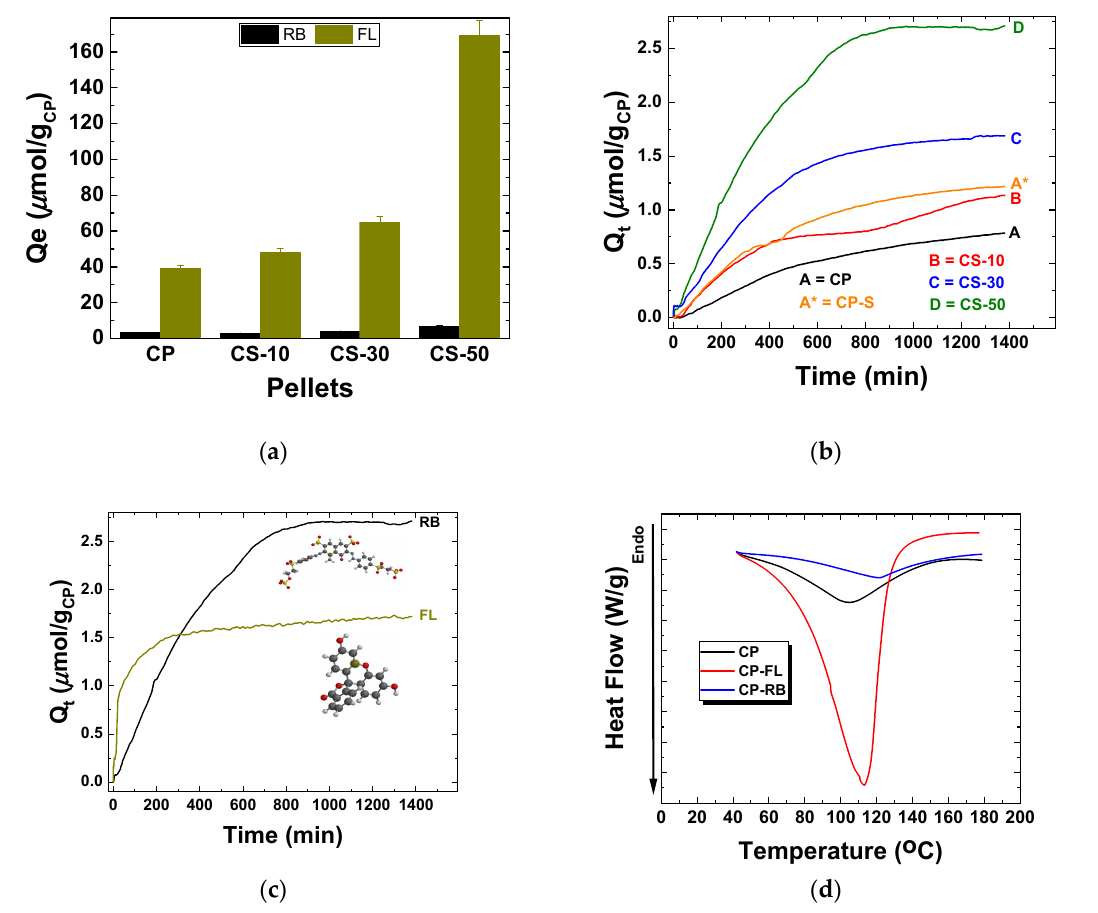
Figure 6. ( a,b ) Equilibrium and in situ kinetic uptake of reactive black (RB) by CP, CP-S, CS-10, CS-30, CS-50, respectively; ( c ) in situ kinetic uptake of RB and fluorescein (FL) by CS-50, and ( d ) DSC profiles for the CP system before and after adsorption of each dye. Table 2. T max values and the change in transition enthalpy ( Δ trs H) from DSC for the single components and the composite materials.